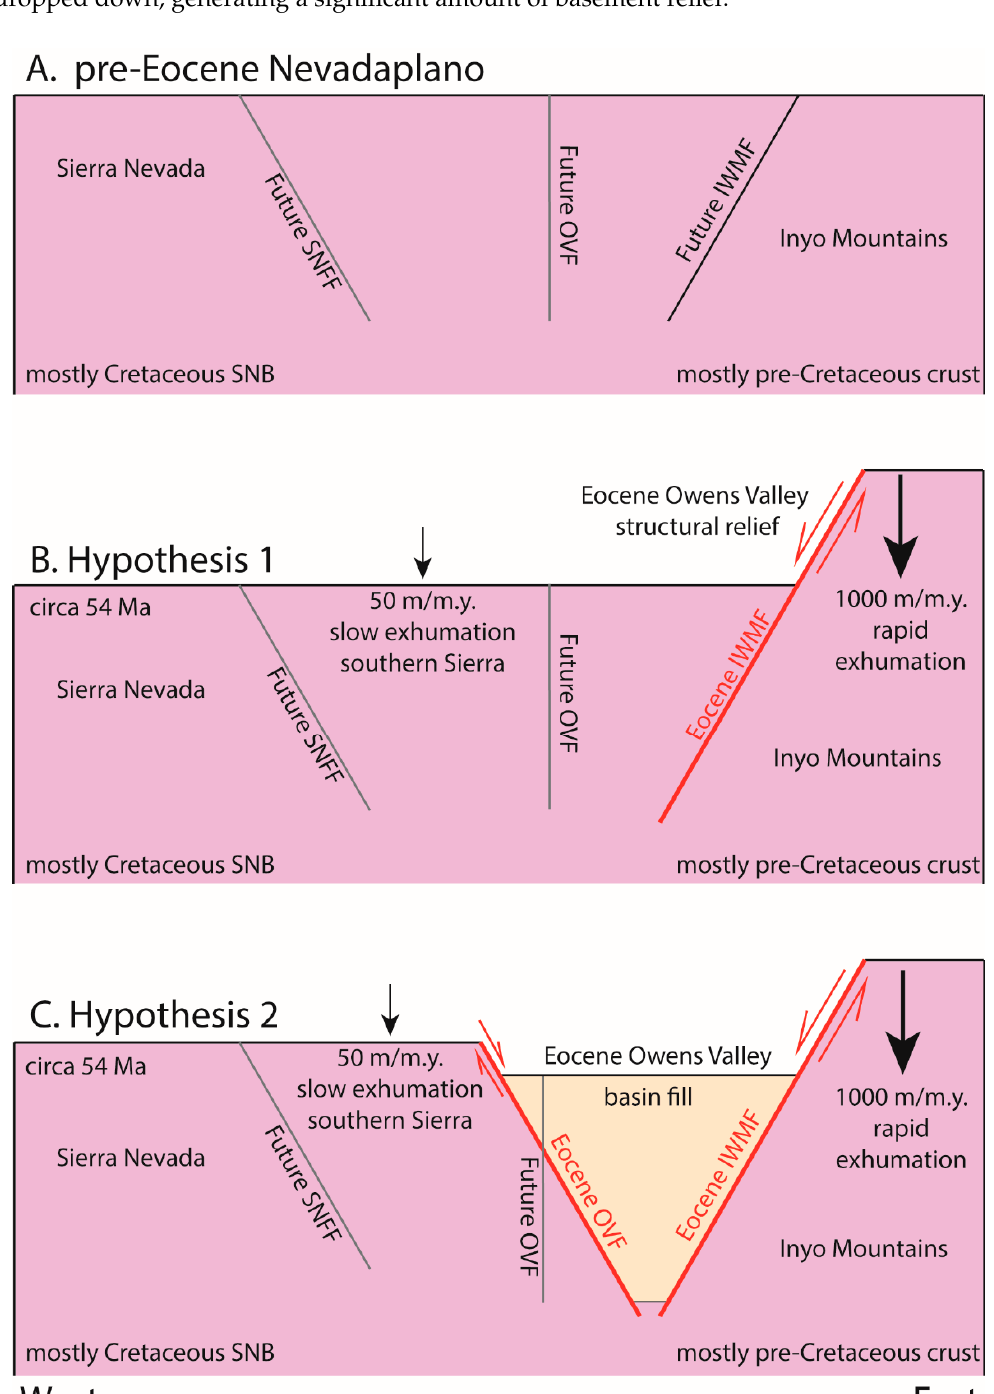
Figure 5. Schematic cartoon depicting the structural evolution of Owens Valley described in hypotheses 1 and 2. A. Before Eocene time, the Nevadaplano is continuous with the proto-southern Sierra Nevada. B. Hypothesis 1 with west-down normal faulting developing along the Eocene Inyo-White Mountains fault. C. Hypothesis 2 with normal fault activity on both the Eocene Owens Valley Fault and Inyo-White Mountains Fault. The beige shaded area is the Eocene Owens Valley basin fill. SNFF: Sierra Nevada Frontal Fault. OVF: Owens Valley Fault. IWMF: Inyo-White Mountains Fault. SNB: Sierra Nevada Batholith.